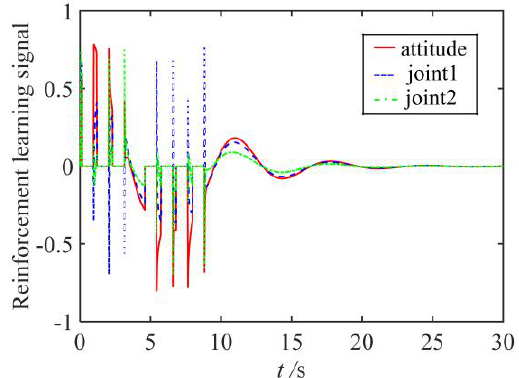
Figure 13. Reinforcement signal (F C2 = 80 N · m, F O2 = 10 N · m).